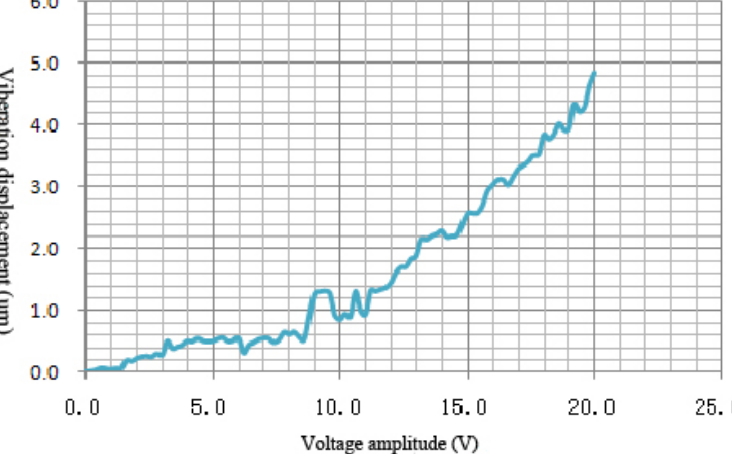
Fig.5 corresponding relationship between response amplitude and excitation